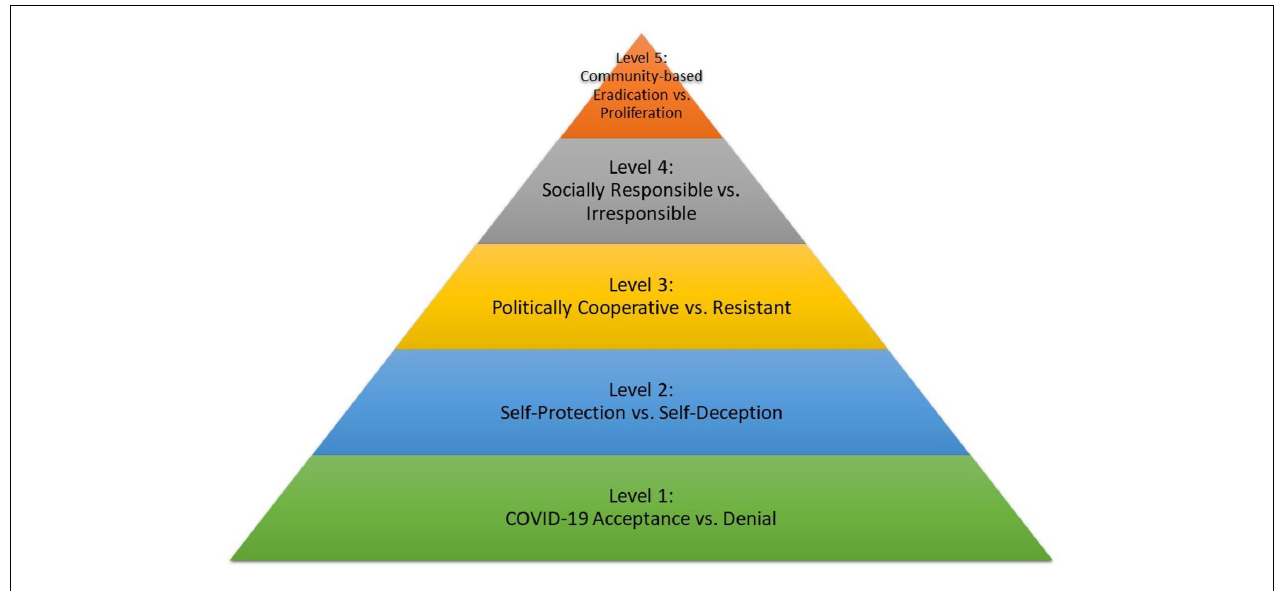
FIGURE 2 | COVID-19 mindset